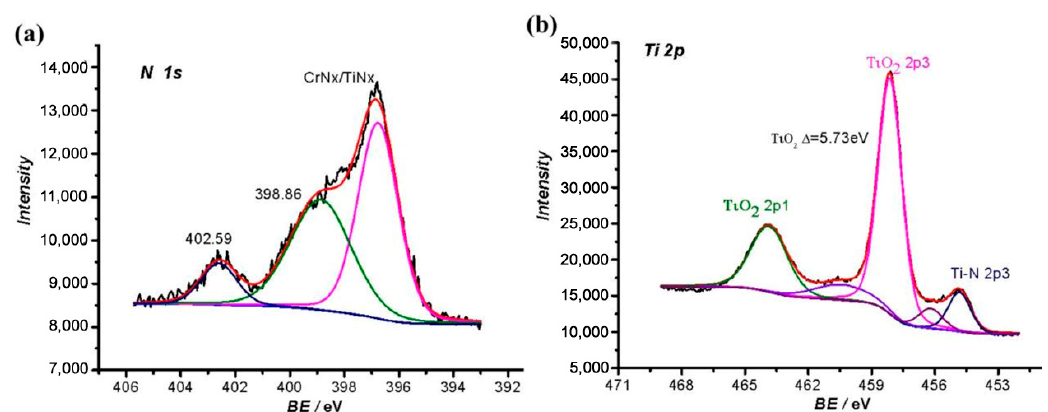
Figure 6. XPS spectra of ( a ) N1s and ( b ) Ti2p measured from the N + + Ti + ‐ implanted M50 bearing steel specimen M1.